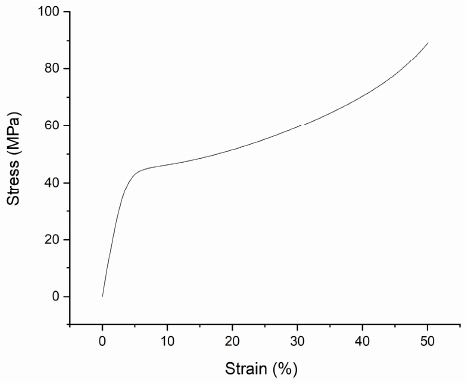
Figure 7. Compression stress-strain curve of solid PLA specimen.